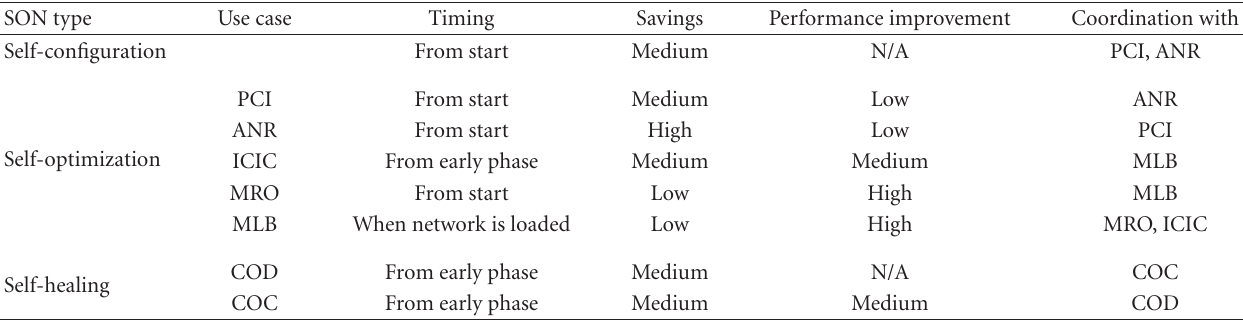
Table 1: Highlights of some important SON